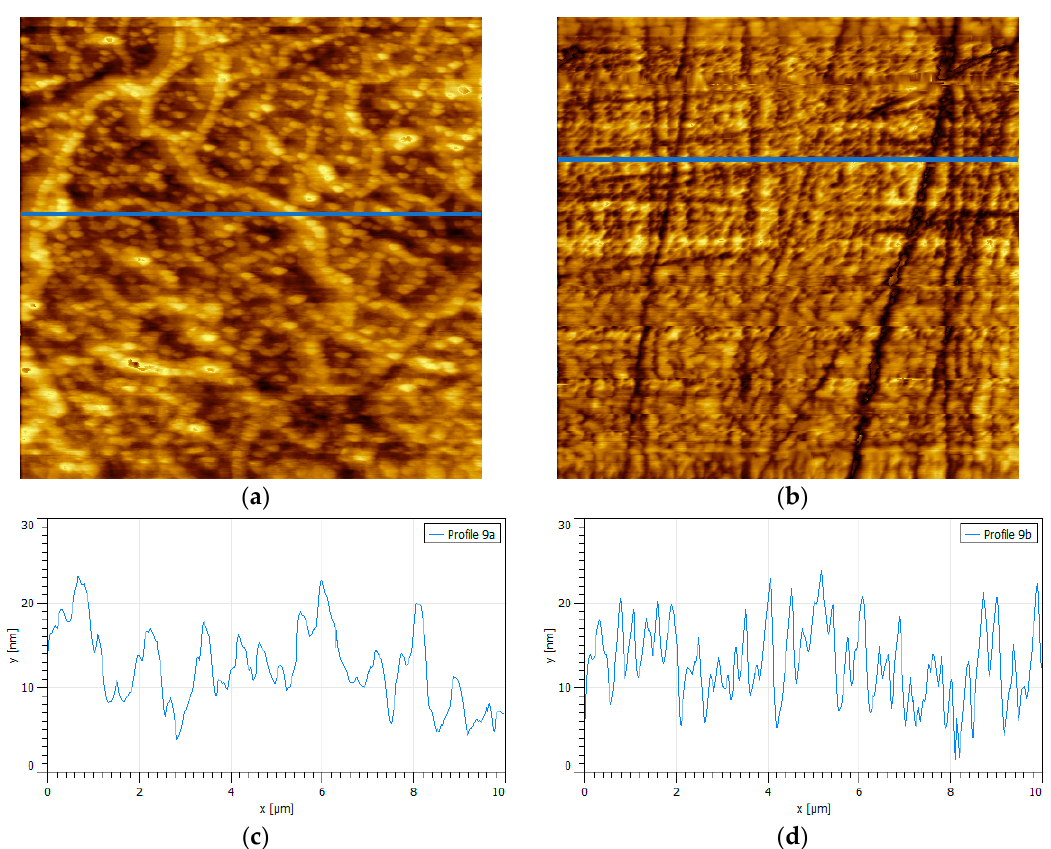
Figure 7. Surfaces {100} of oxidized pyrite exposed to PAX and magnesium chloride at pH 8.5, scan size is 10 × 10 μ m 2 . ( a ) 0.01 M MgCl 2 , 10 − 4 M PAX; ( b ) 0.5 M MgCl 2 , 10 − 4 M PAX, ( c ) and ( d ) are the corresponding height profiles (blue line in the images). Table 1. Summary of average height/width of the different peaks for pyrite at different conditions. Figure Pyrite Conditions <Height> nm <Width> nm 1a Polished with 1 micron paste 0.4 - 1b Polished with 0.25 micron paste 0.35 -